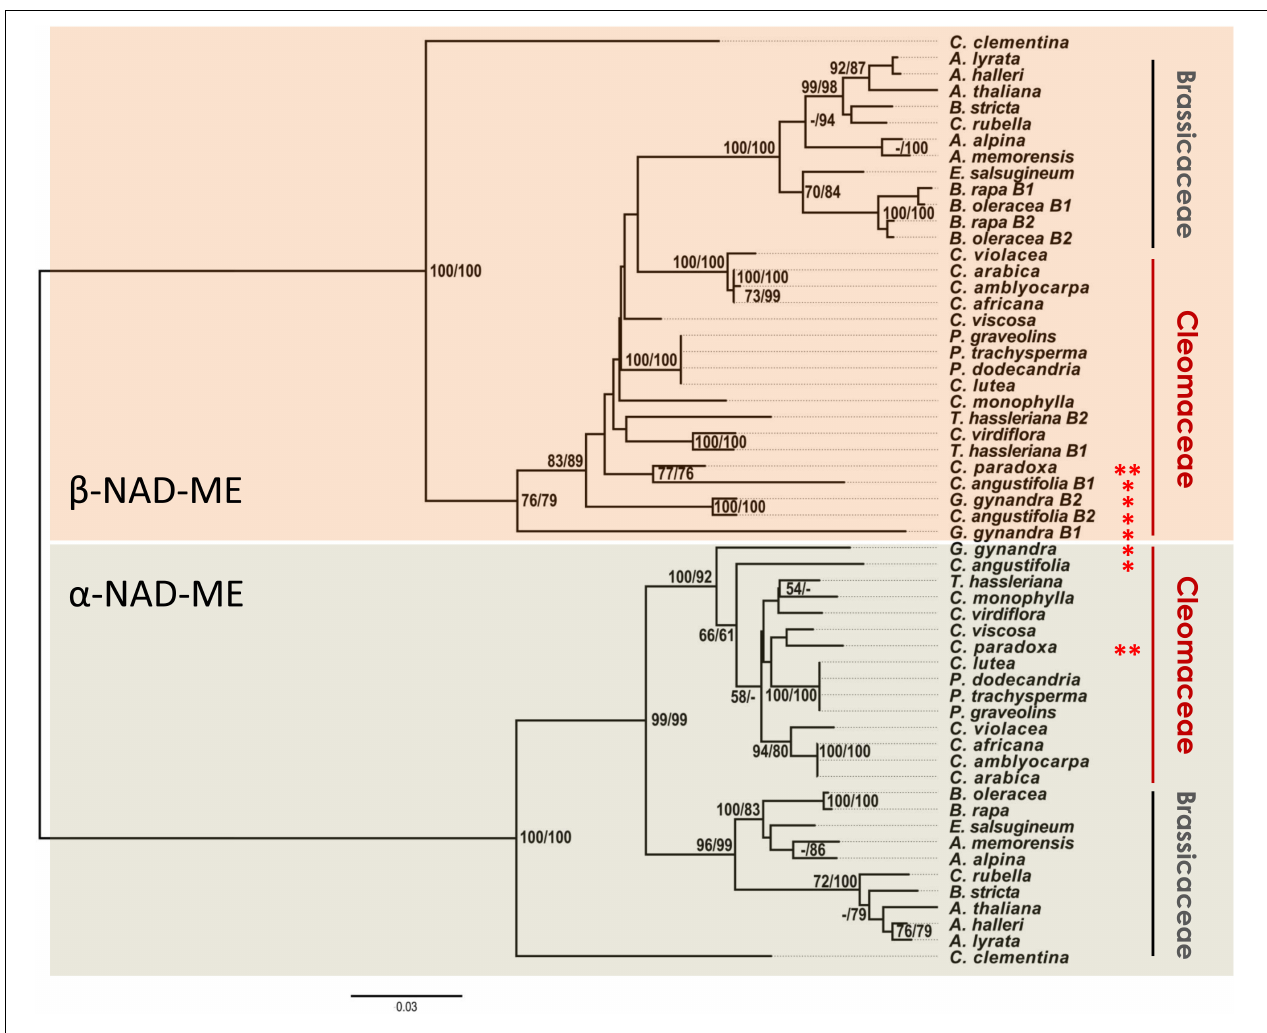
FIGURE 3 | Phylogenetic gene tree of NAD-ME proteins of Cleomaceae and Brassicaceae. The evolutionary history was inferred using the ML and NJ methods. The NJ optimal tree with the sum of branch length = 1.58 is shown. The tree is drawn to scale, with branch lengths measured in the number of substitutions per site. The evolutionary distances were computed using the JTT matrix-based method with a discrete Gamma distribution to model evolutionary rate differences among sites (G, parameter = 0.52). Support values of 2,000 bootstrap replicates are given as MLB/NJB next to the branches when greater than 50%. The analysis involved 57 amino acid sequences and there were 227 parsimony-informative sites over a total of 597 positions (less than 40%) in the final dataset. Red ∗ and ∗∗ indicate C 4 and C 3 –C 4 photosynthetic metabolism, respectively. Citrus clementina NAD-ME isoforms were used as out groups. The full trees are available in Supplementary Data 4 and Supplementary Data 5